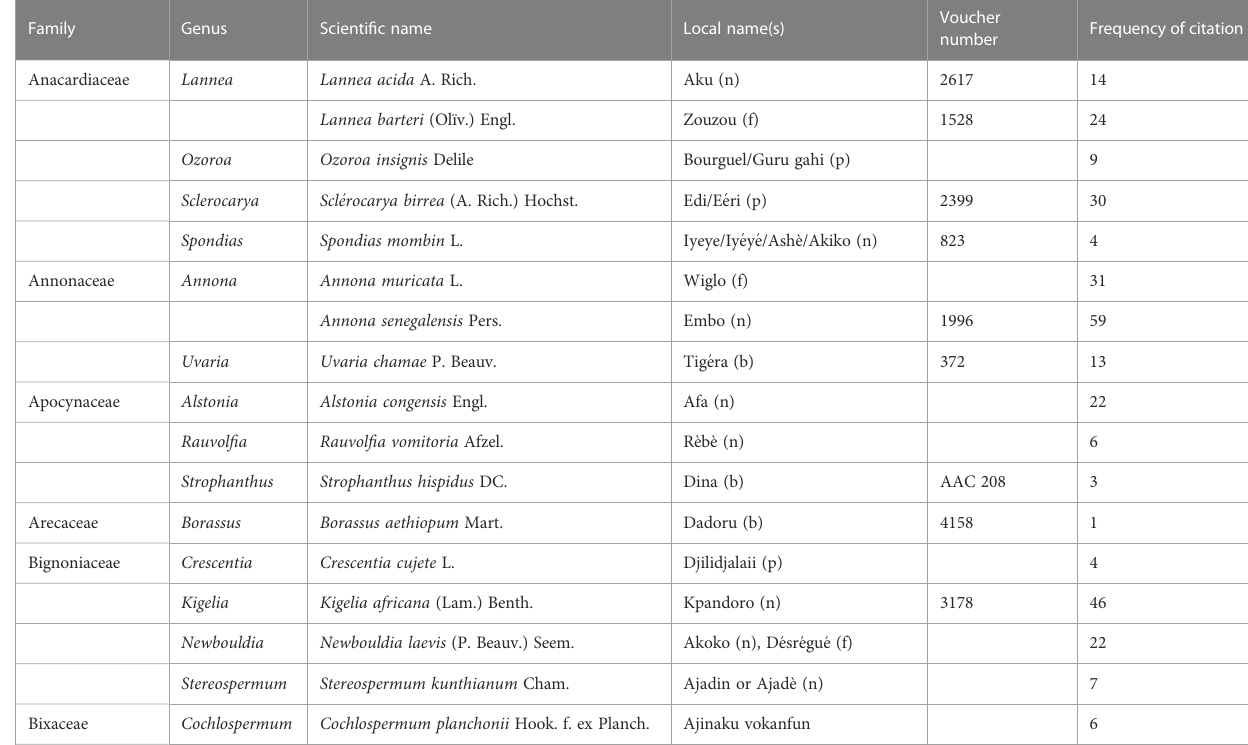
TABLE 2 Number of cited